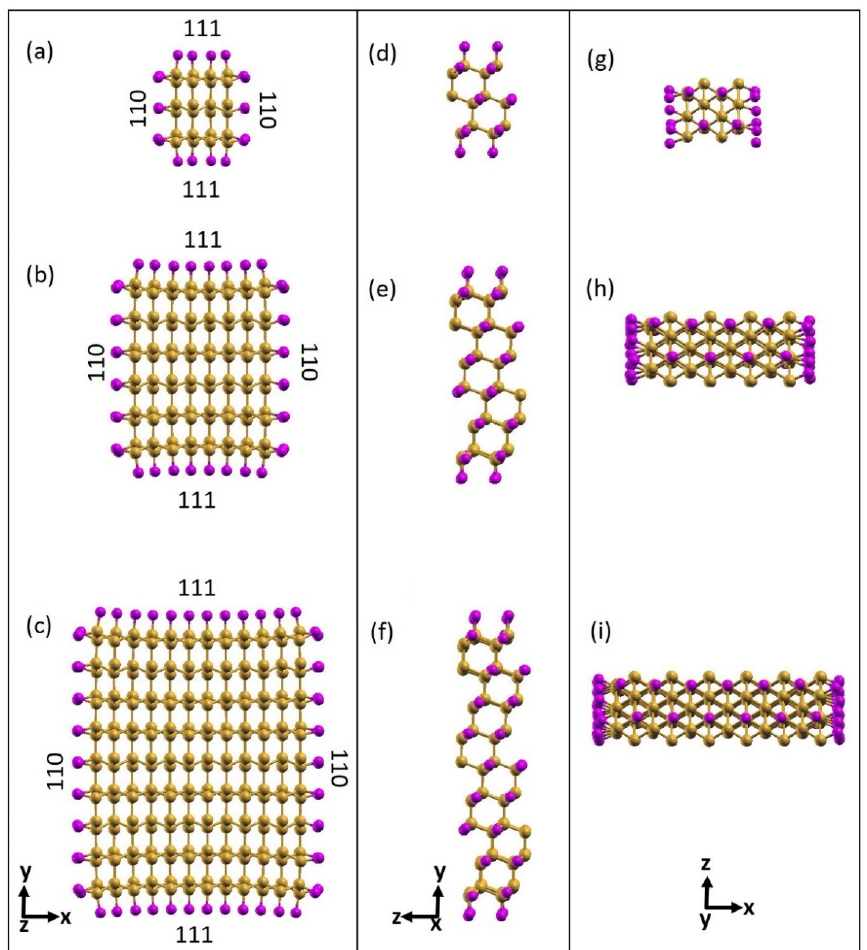
Figure 1. Optimized atomic structures of fully passivated Cl-SiNWs (magenta color: Cl atoms; mus- tard color: Si atoms). ( a , d , g ) Si 216 Cl 60 ( d = 2.64 nm); ( b , e , h ) Si 96 Cl 40 ( d = 1.671 nm); and ( c , f , i ) Si 24 Cl 20 ( d = 0.71 nm). Left column: cross sections of the <112> Cl-SiNWs enclosed with (111) and (110) facet; central column: side view of the <112> Cl-SiNWs showing the top of the (110) surface; right column: side view of the <112> Cl-SiNWs showing the top of the (111) surface.